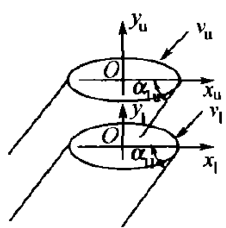
Figure 12 (left) Y6 prototype used for test (equipped with 28-inch blades) Figure 13 (right) 8-rotor LiDAR system (cited from Reference 8)